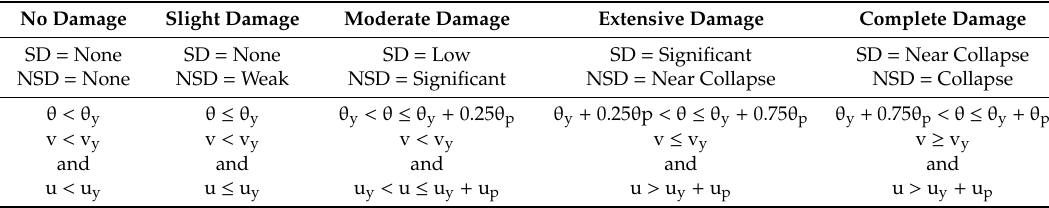
Table 2. Damage States Definition for RC Frames According to the Displacement Capacity of Structural and Non-Structural Elements.